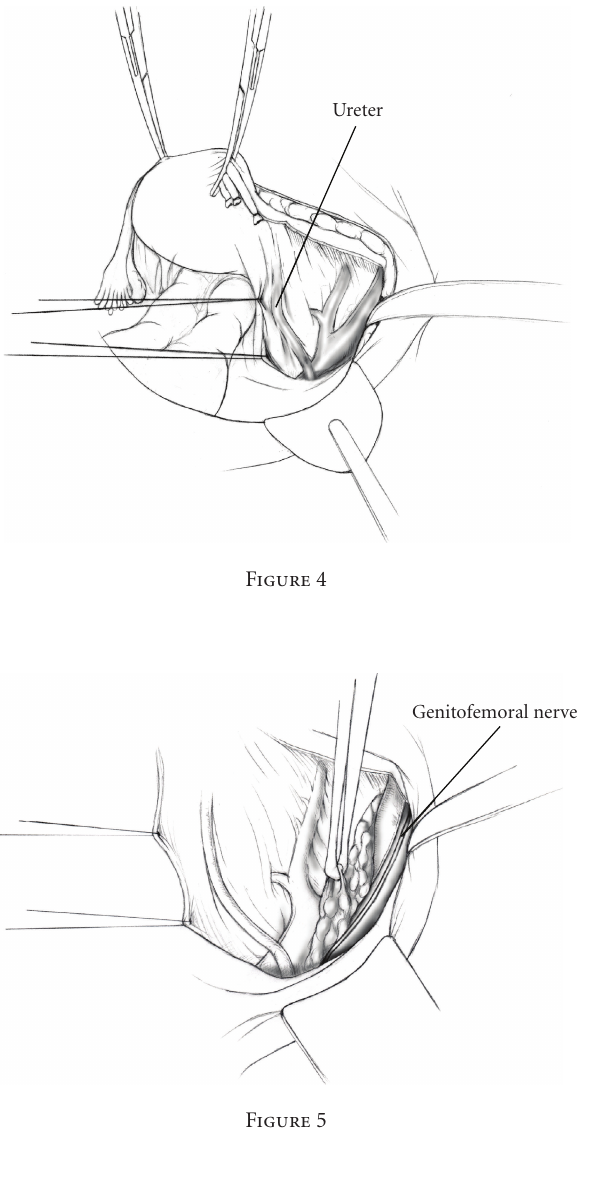
subcutaneously prior to surgery and three times daily in the postoperative period for thromboembolic prophylaxis. In addition, sequential compression devices (SCDs) are placed on both lower extremities immediately prior to surgery, and are left in place until the patient is ambulating